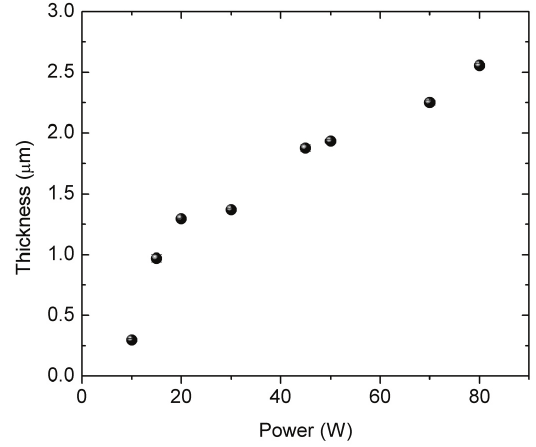
Figure 2. Thickness of the films as a function of power for discharges composed of 50% of HMDSO and 50% of O